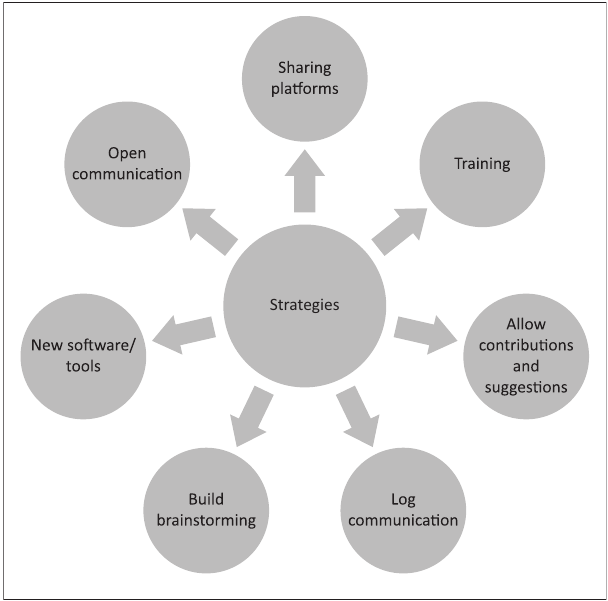
FIGURE 6: Strategies for overcoming challenges of collaboration in public organisation.